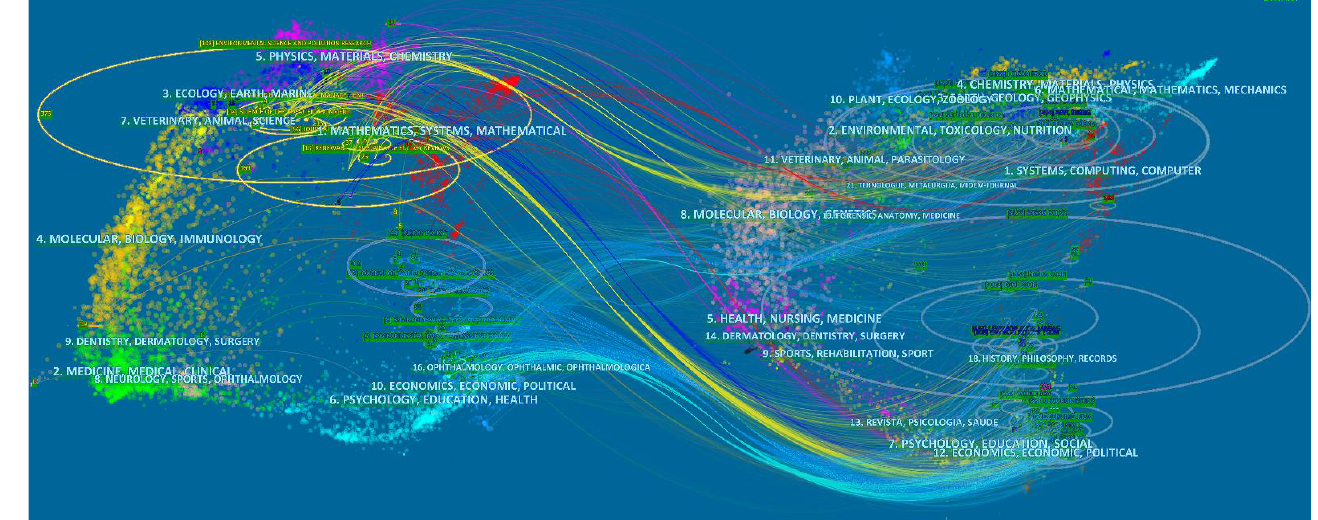
Figure 3. Dual-map overlay analysis of the relevant discipline.